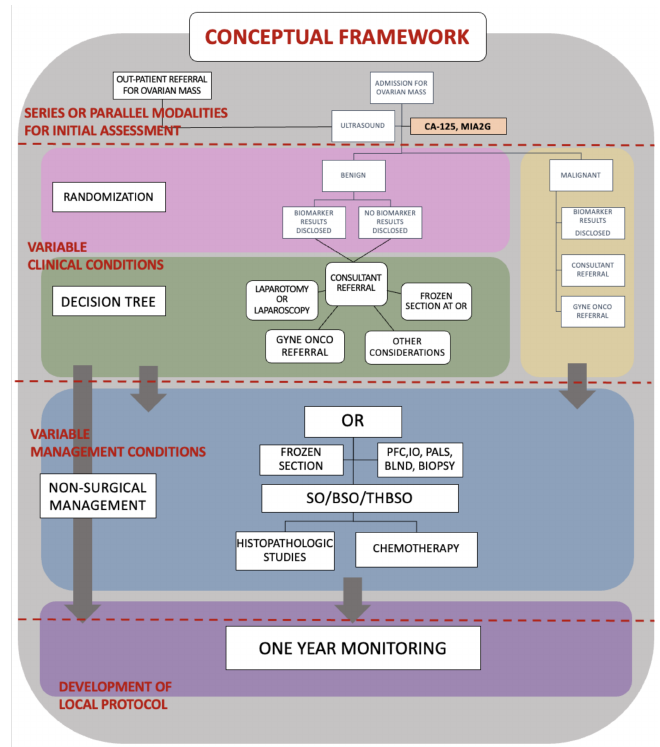
Figure 1. Conceptual framework and methods of the